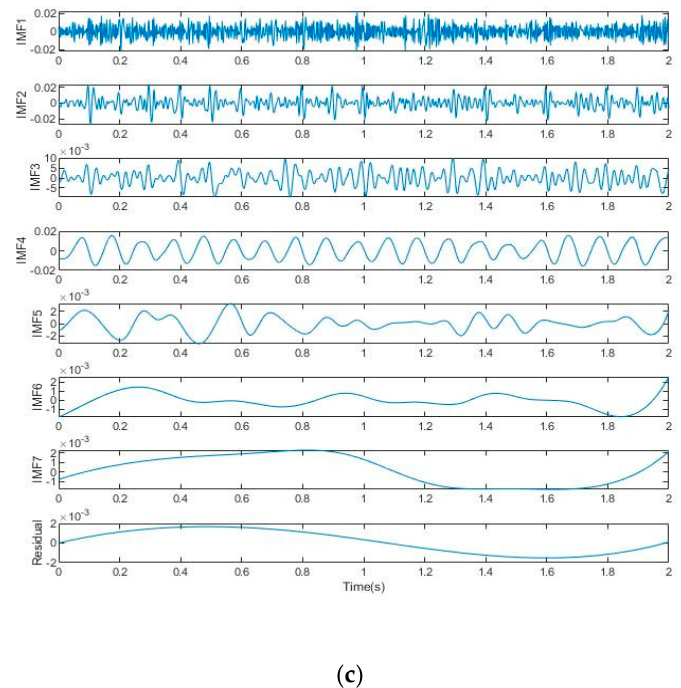
Figure 4. Decomposition diagram of noisy signal: ( a ) EMD decomposition; ( b ) EEMD decomposi- tion; ( c ) CEEMD decomposition.